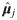
Directed annotations partially explain gene expression variance in GTEx.The BAGEA model was fit using various GTEx eQTL data (supplemented with GEAUVADIS eQTL data) and with ExPecto-derived directed annotations on genes in the trainig set (chr1,‥,chr15) with a top nominal p-value<10−7. ExPecto includes 2002 total annotations, of which either 1187 histone and DHS annotations from Roadmap (Roadmap) or 690 non-histone ChIP-Seq from ENCODE (TF) were used. For the Roadmap annotation set we enforced structure on the priors of ω by using the meta-annotations available for cell type and assay type, (group-lasso), while for the (TF annotation set, each ωi parameter be controlled by its individual υi parameter (lasso). For each gene j in the test set (chr16,‥,chr22 and top nominal p-value< 10−7), we calculated an approximate version of Sj, the squared magnitude of the directed predictor μ^j, where the approximation uses external LD information. Further, we calculated an approximate version of MSEjdir, the mean squared error (MSE) when predicting gene expression yj from μ^j. (A) Displayed is the average (approximated) MSEjdir across all genes for each GTEx experiment, and annotation subset. 95% Confidence intervals are computed by bootstrap sampling. (B) For each GTEx experiment and annotation subset, we sorted results by predictor size Sj and and averaged MSEjdir within the top quartile. Displayed is the relationship between the MSE of the predictor and its mean squared magnitude Sj. Averaged
Sj, top quartile
Sj¯|Sj>FSj-1(0.75): The mean value of the directed predictor size Sj in the top quartile on the horizontal axis; Averaged Directed MSE (MSEdir¯): The averaged MSEjdir of genes falling into the top quartile in terms of Sj on the vertical axis. The 95% confidence interval for each window was derived by bootstrap sampling. We see that the average squared magnitude Sj is of similar size as the gains in directed MSE suggesting that the BAGEA does not substantially overfit.